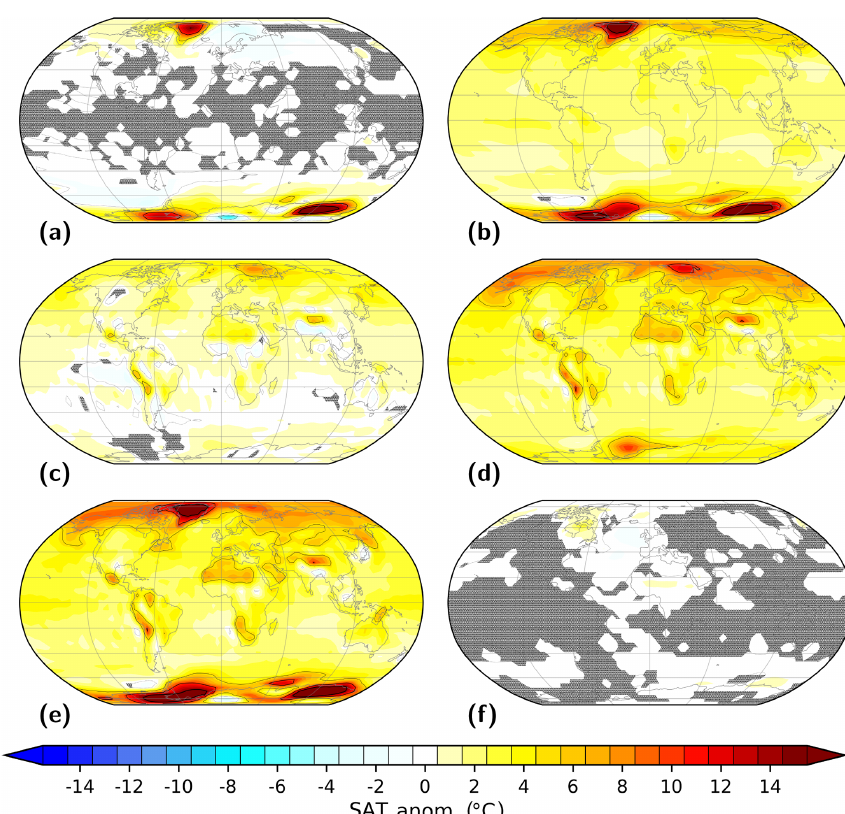
Figure 26. Sensitivity of annual mean surface air temperature (SAT) to variations in geography. Shown are anomalies with respect to pre- industrial (E280) for simulations (a) Ei280, (b) Ei400, (c) Eo280, (d) Eo400, and (e) Eoi400_GW. Panel (f) illustrates the impact of gateway changes in simulation Eoi400_GW in comparison to simulation Eoi400. Contours illustrate isotherms of − 5 ◦ C (dashed, thin), 0 ◦ C (dotted, thin), 5 ◦ C (solid, thin), 10 ◦ C (solid), and 15 ◦ C (solid, thick). In hatched regions the anomaly is insignificant at the 95% confidence interval based on a t test. We define SAT as the temperature at a height of 2m above the